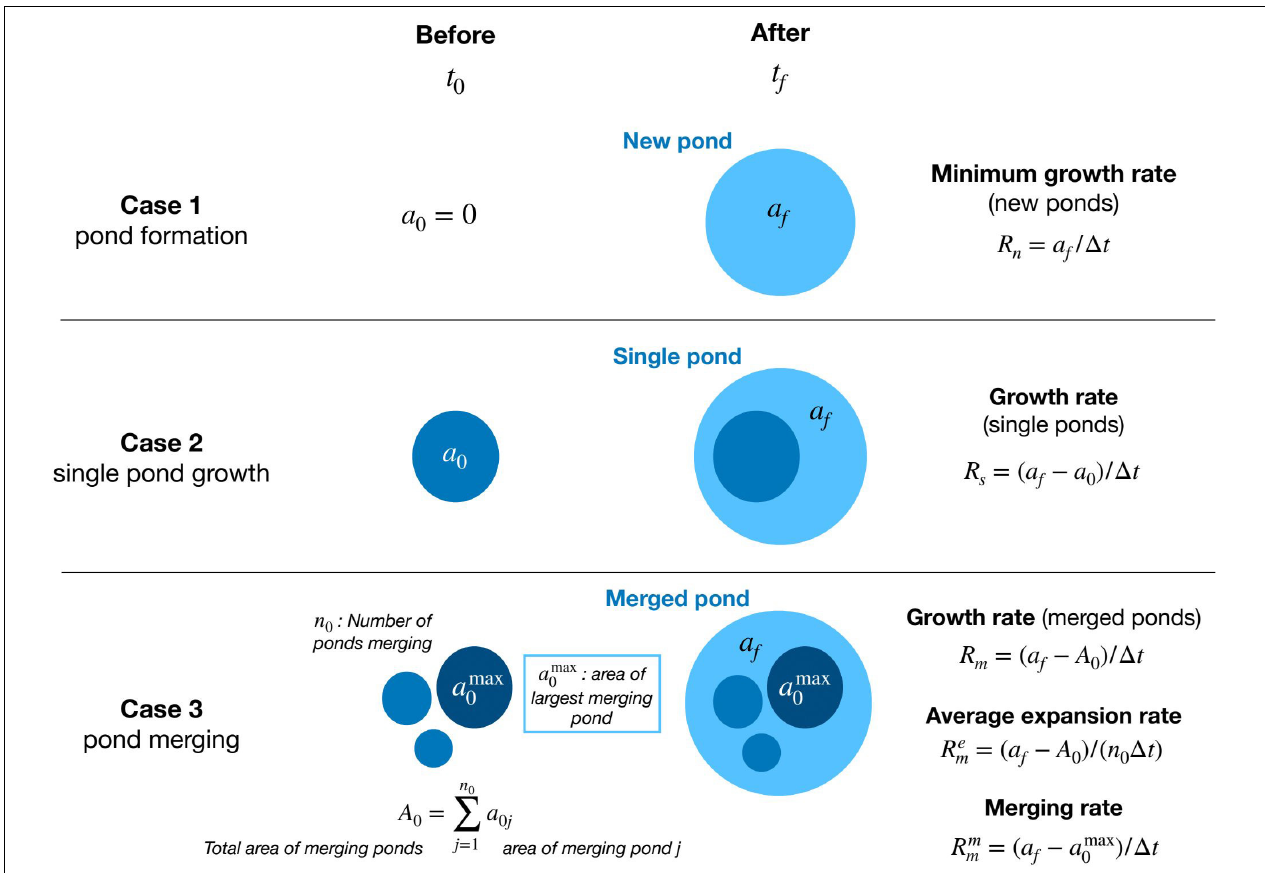
FIGURE 2 | Contrasting cases of pond growth, from two consecutive images at times t 0 and t 1 = t 0 + (cid:49) t, and the respective area growth rates (see text for explanation of formulas).